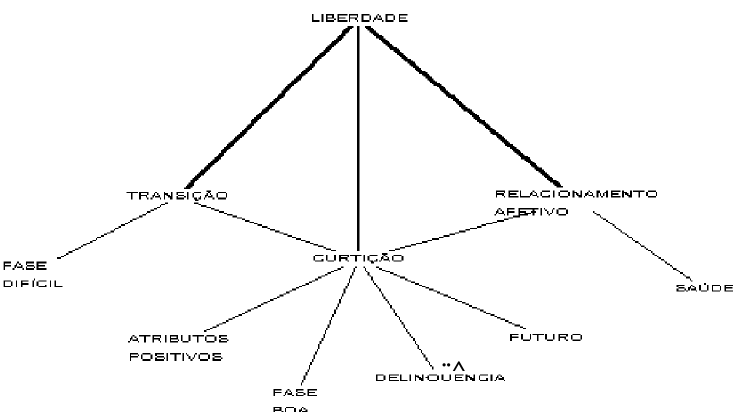
Figura 3. GrÆfico de anÆlise de similitude das categorias relacionadas (cid:224) adolescŒncia entre os sujeitos da capital ( n =180).